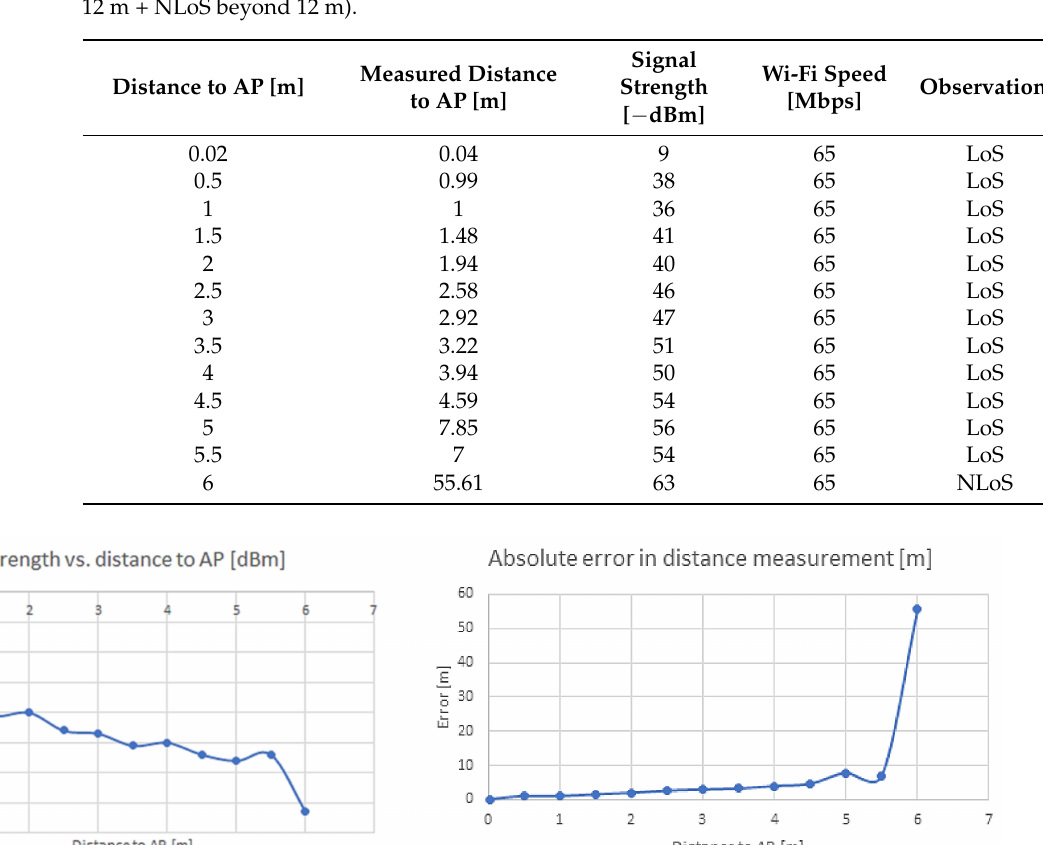
Table 4. Recorded values of signal strength, Huawei AP, mixed indoor environment (LoS from 0 to 12 m + NLoS beyond 12 m).